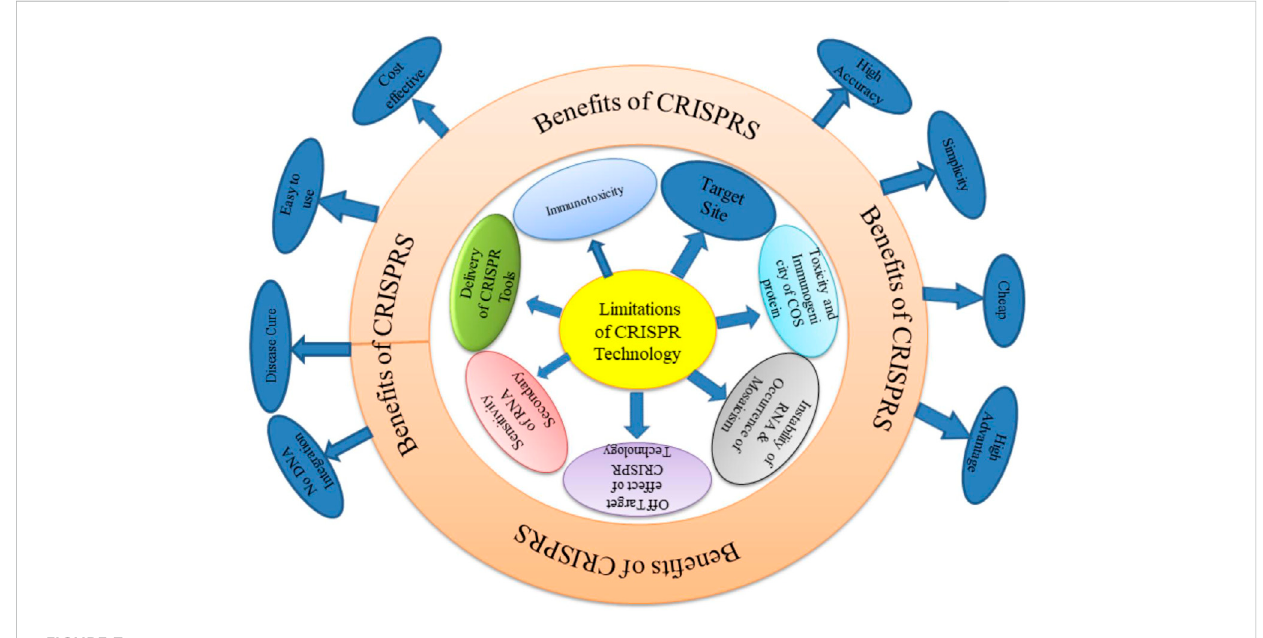
FIGURE 7 Limitations and bene fi ts of CRISPR